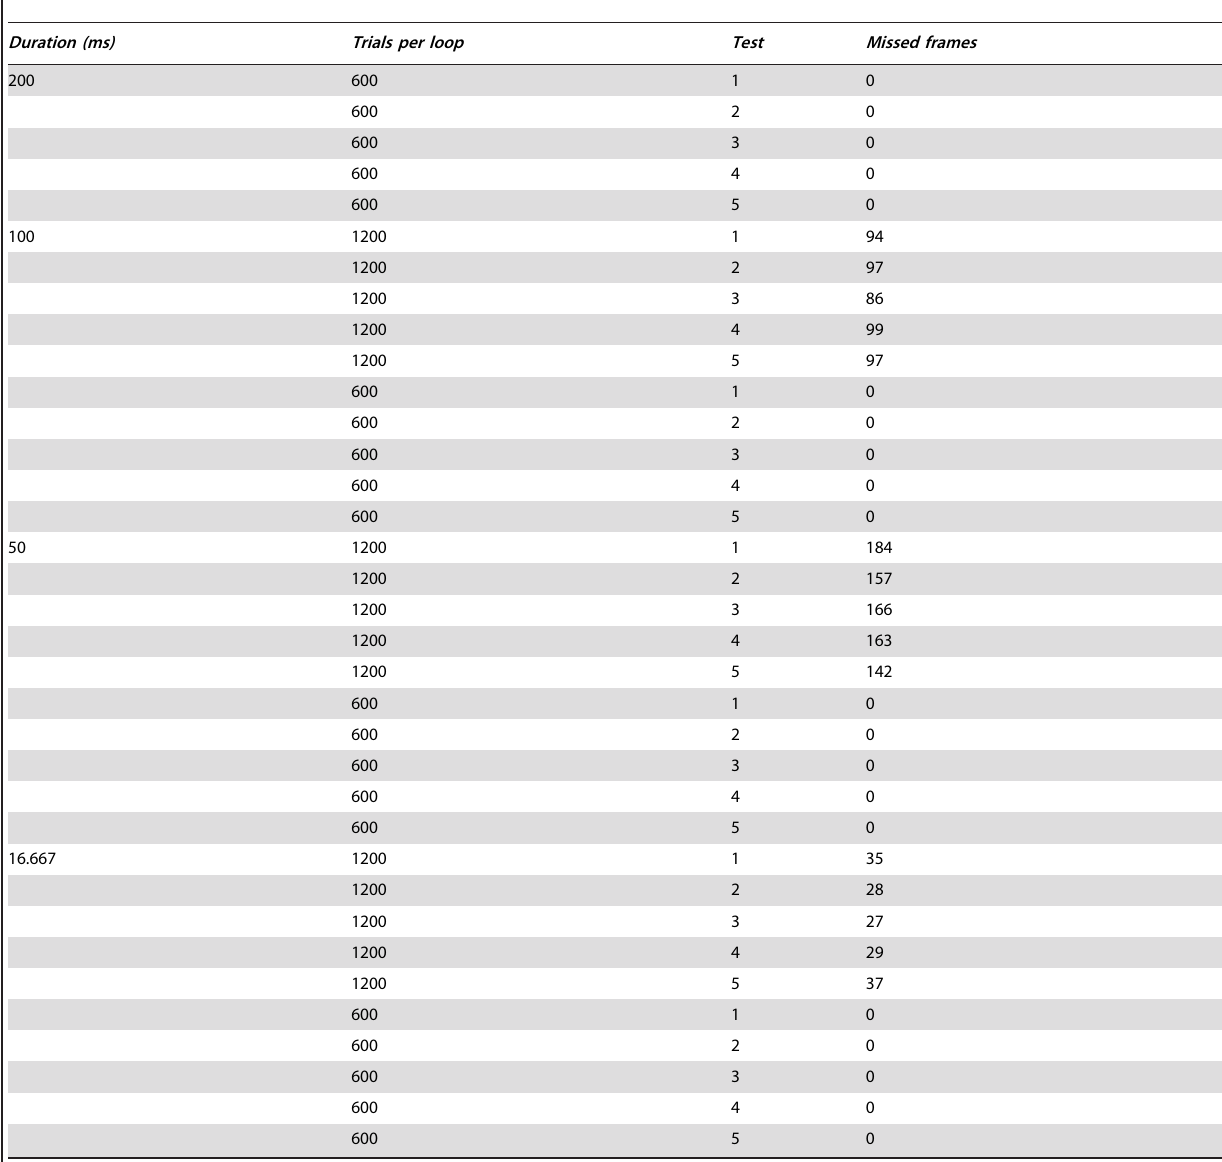
Table 6. PsychoPy 1.80 timing tests on MacBook Pro Mid 2009 under Ubuntu Linux 13.10 ‘‘Saucy